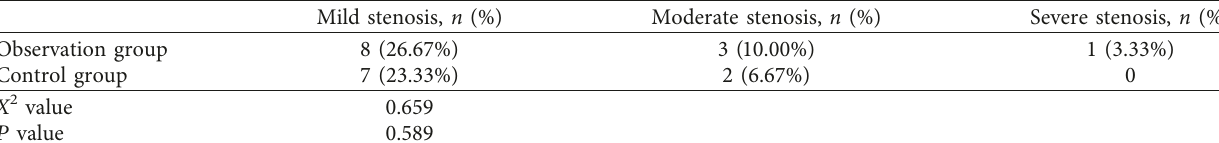
Table 3: Different gradings of ipsilateral ICA stenosis.